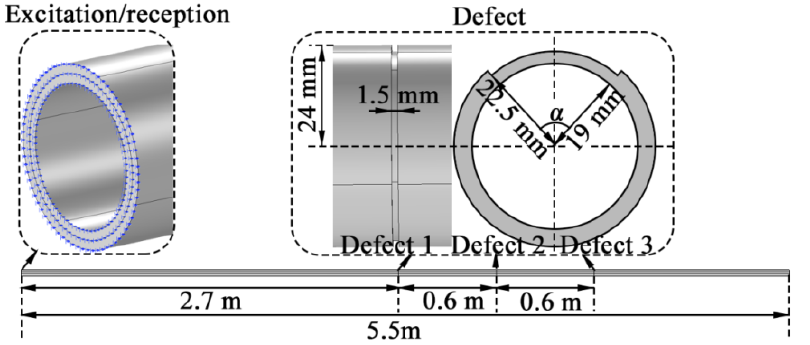
Figure 11. Schematic diagram of the pipeline and defects.